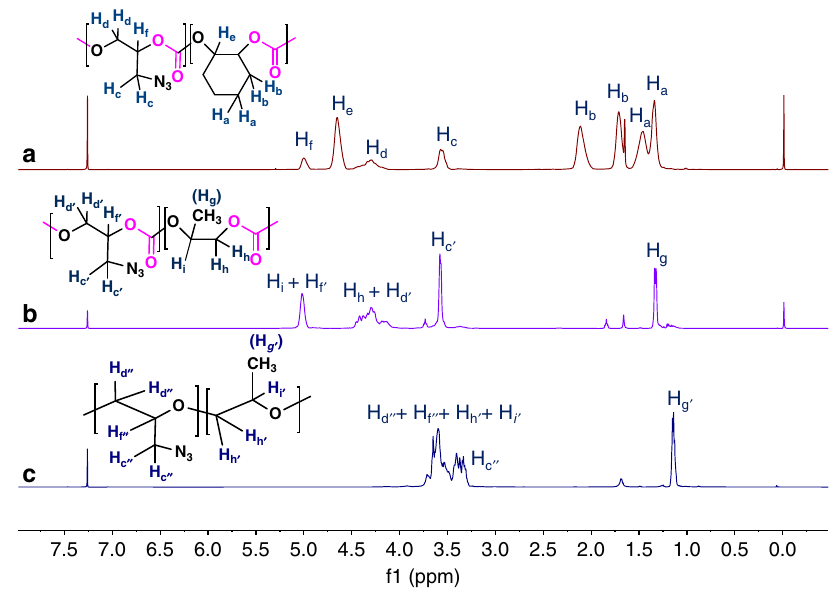
Fig. 7 1 H NMR spectra of random copolymer samples of entry 1 – 3, Table 3 obtained through terpolymerization or copolymerization of GA with CHO(PO)/ CO 2 and with PO. a , b Indicate the random incorporation of GA in polycyclohexene carbonate and polypropylene carbonate backbone. c Displays the random incorporation of GA in poly(propylene oxide). Reaction conditions for a : GA/CHO /Bu 4 NN 3 /TEB = 20/80/1/1 and for b : GA/PO/Bu 4 NN 3 / TEB = 20/80/1/1 at 25 o C and CO 2 (10 bar). For c : GA/PO/Oct 4 NBr/TEB = 50/50/1/5 at 0 o